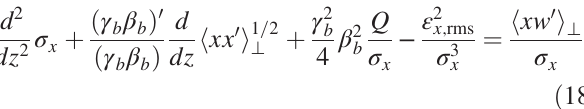
FIG. 5. Stopping power S ð E (mass density ρ ¼ 2 . 7 g = cm 3